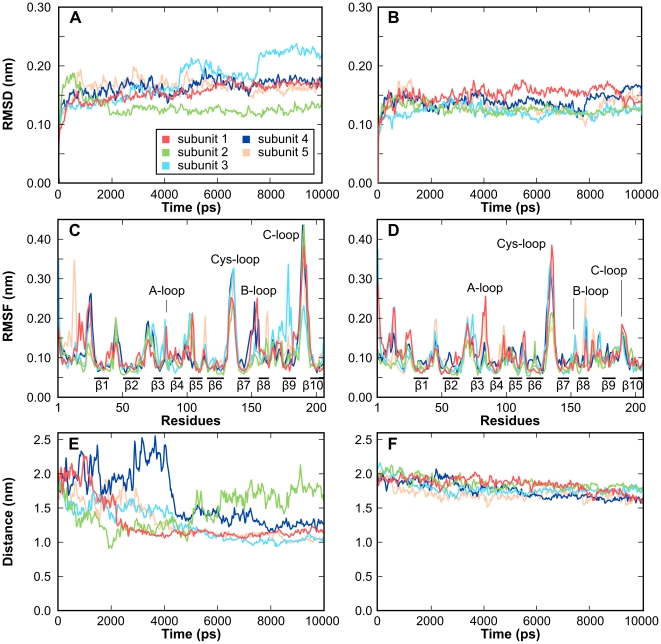
Analysis of the stability of α7-nAChR over 10 ns molecular dynamic simulations in the apo (A,C,E) and ImI-bound (B,D,F) states.β strand α carbon root-mean-square deviations (RMSD) of each of the subunits over the molecular dynamics simulations to the starting frame for the apo (A) and ImI-bond models (B). α carbon root-mean-square fluctuation (RMSF) of each subunit of the apo (C) and ImI-bond (D) models. Fluctuation of the distance between the sulfur atom of α7-C190 side chain and the α carbon of α7-Y32 in the apo (E) and ImI-bond (F) models. This distance characterizes the closure of the C-loop. The RMSD is calculated using Cα atoms in β strands. The RMSD and distances were averaged using a 16 ps window.